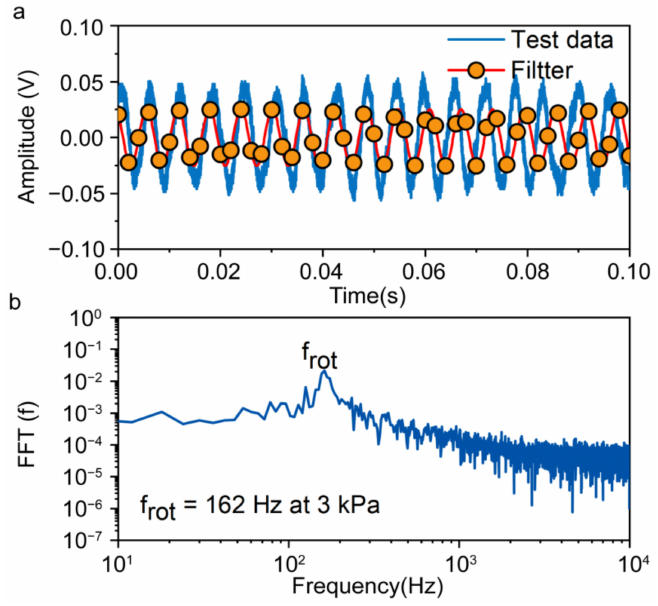
Figure 14. Test of rotation signal under a vacuum environment of 3 kPa. ( a ) Time domain signals; ( b ) Frequency domain